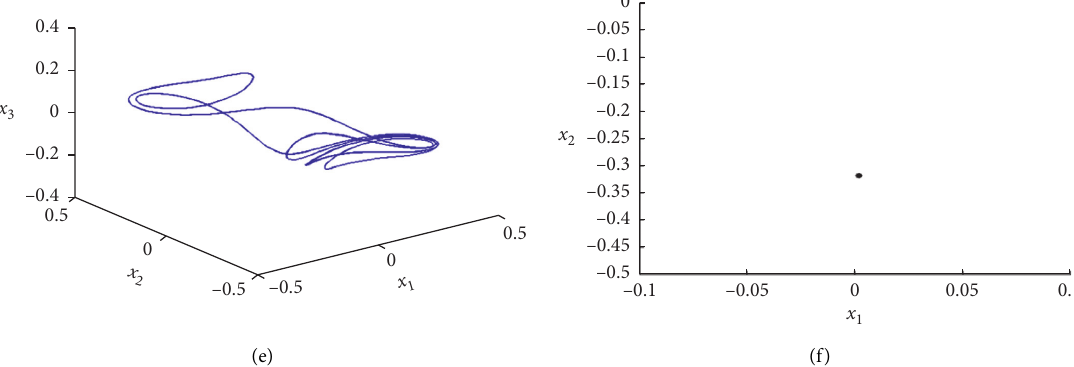
Figure 15: The multitime periodic oscillation of the cantilevered pipe conveying pulsating fluid is obtained when the external excitation is F � 4 . 5. (a) Phase portrait on plane ( x ( t, x ) , (e) three-dimensional phase portrait in space ( x 3